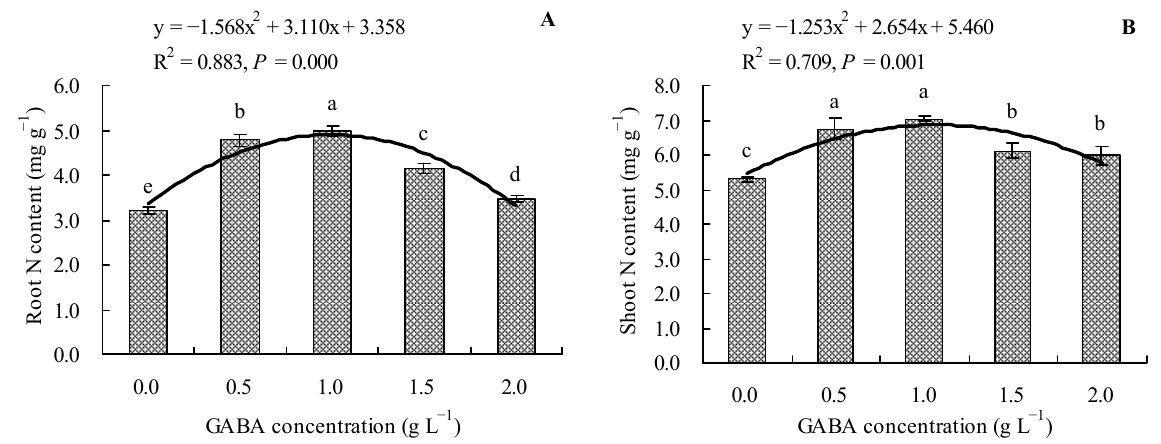
Figure 2. Total N content in loquat seedlings under the influence of gamma amino butyric acid. ( A ): Root N content; ( B ): shoot N content. Values are means ( ± SD) of three replicates. Different lowercase letters indicate significant differences among the treatments (Duncan’s Multiple Range Test, P < 0.05). GABA = gamma amino butyric acid.